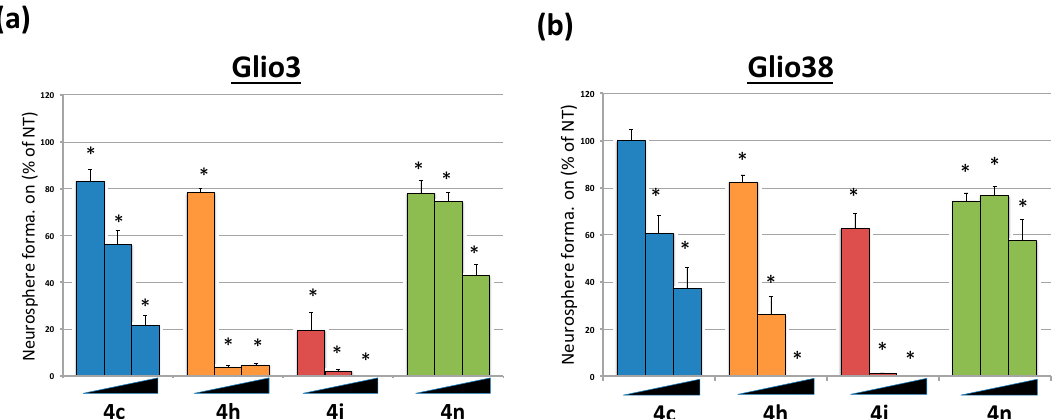
Figure 4. Bis-chalcones 4c, 4h, 4j, 4n significantly reduce neurosphere formation. GSCs Glio3 and Glio38 were plated as single cells in 96-well plates and treated with increasing concentration of 4c, 4h, 4j, 4n (100 nM, 250 nM or 500 nM) and the number of neurospheres counted on day 14. Data is presented as percent neurospheres relative to non-treated controls. ( a ) Glio3; ( b ) Glio38. * p < 0.05.